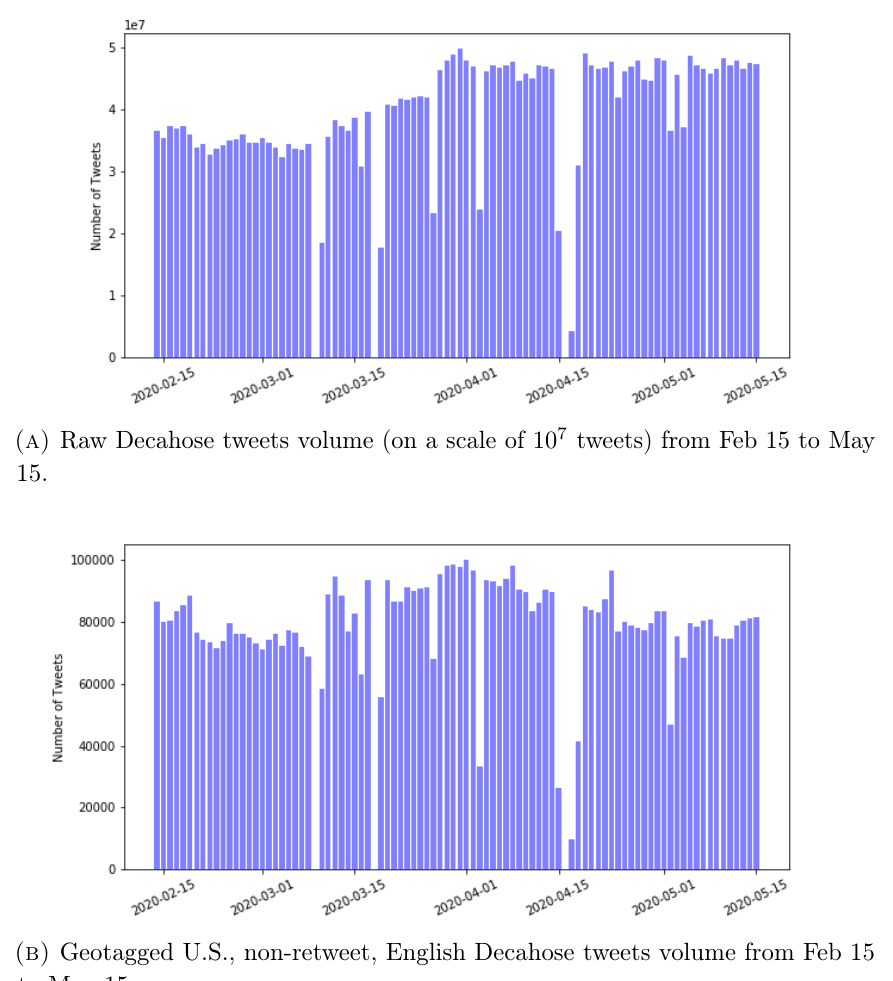
Figure G.1. Volume of all and geotagged Decahose tweets for each day during the study period. The Decahose stream generates around 30 − 50 million raw tweets and 50 − 100 thousand geotagged English language tweets per day, except for